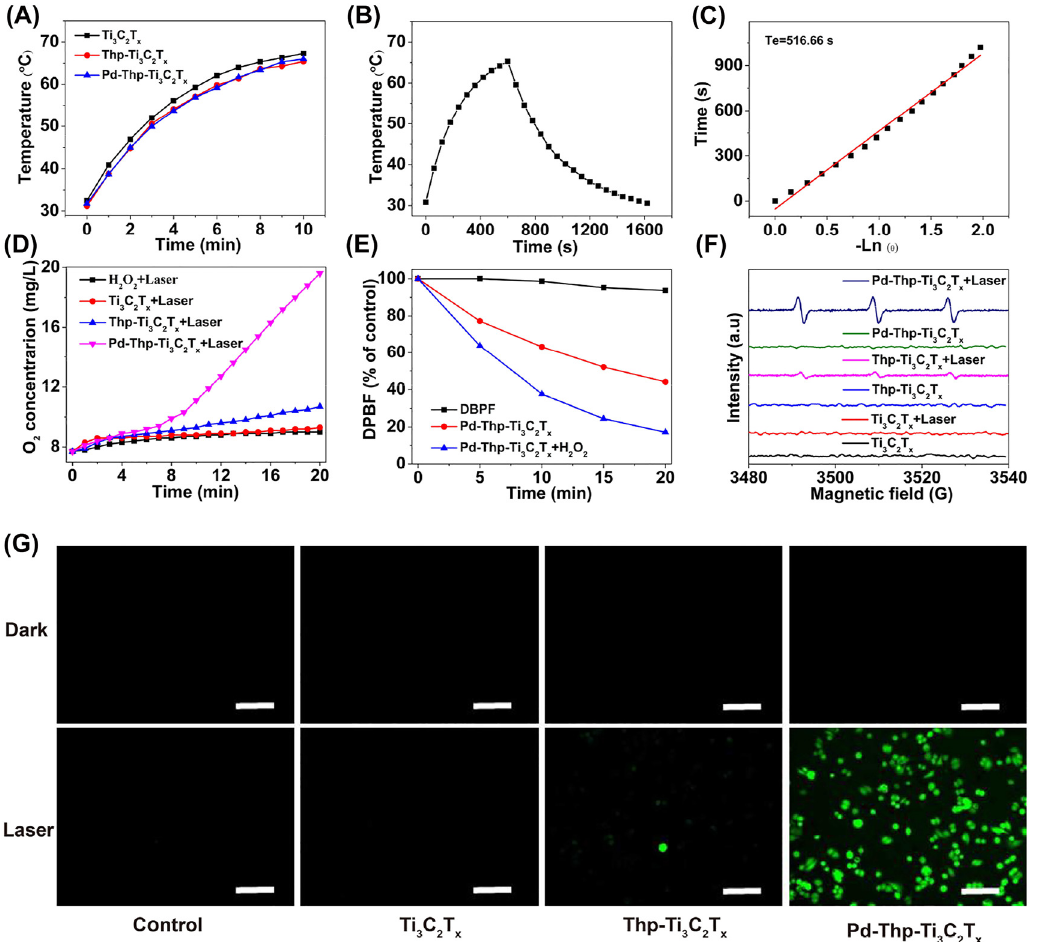
C T , Thp-Ti C T , Pd-Thp-Ti 3 2 3 2 x x